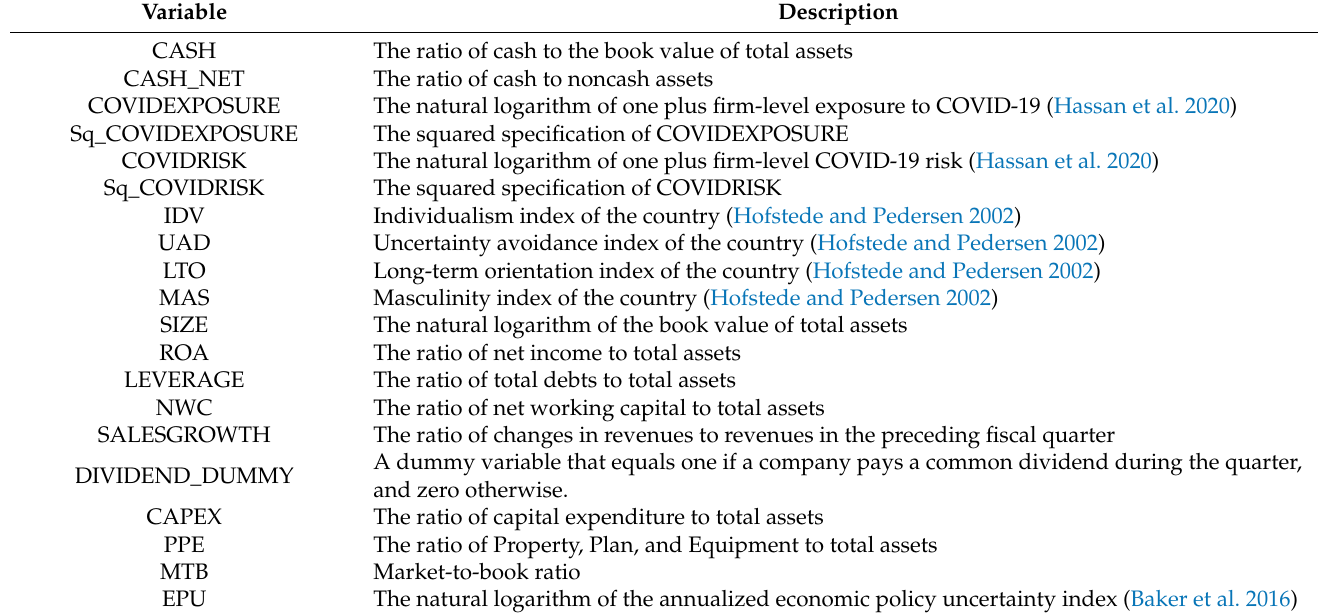
Table 1. Variable